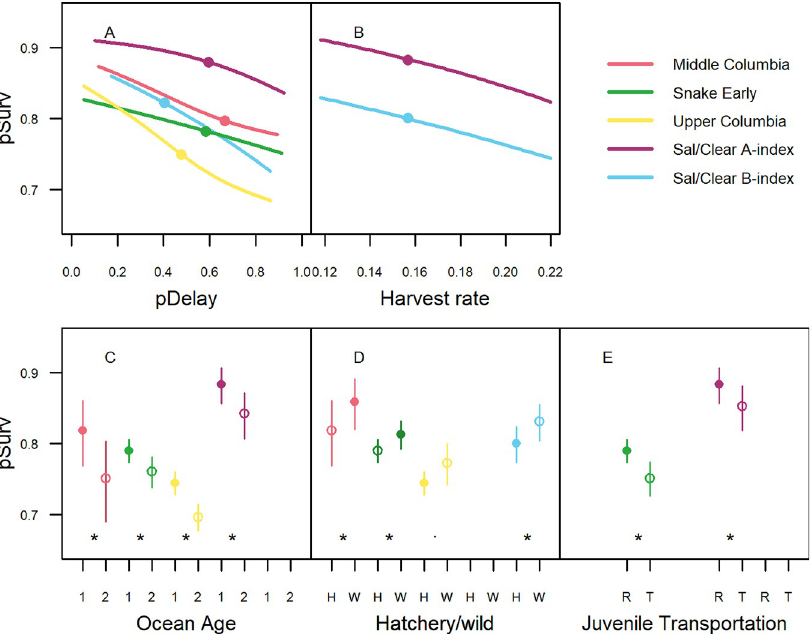
Fig 7. Covariate effects for probability of survival models. All variable effects are shown conditioned on the median or most common value of other variables in the model for the entire dataset. All retained continuous variable effects contributed significantly ( P < 0.05) and are presented for the 95% central extent of variables ranges by population groups with median values shown by points (A and B). Significance of categorical variables is shown by asterisks ( P < 0.05) and periods ( P < 0.1) and 95% confidence intervals are shown with vertical lines. Filled circles in C-E indicate the most common value of each categorical variable. R represents river-run (not transported) while T represents transported juveniles